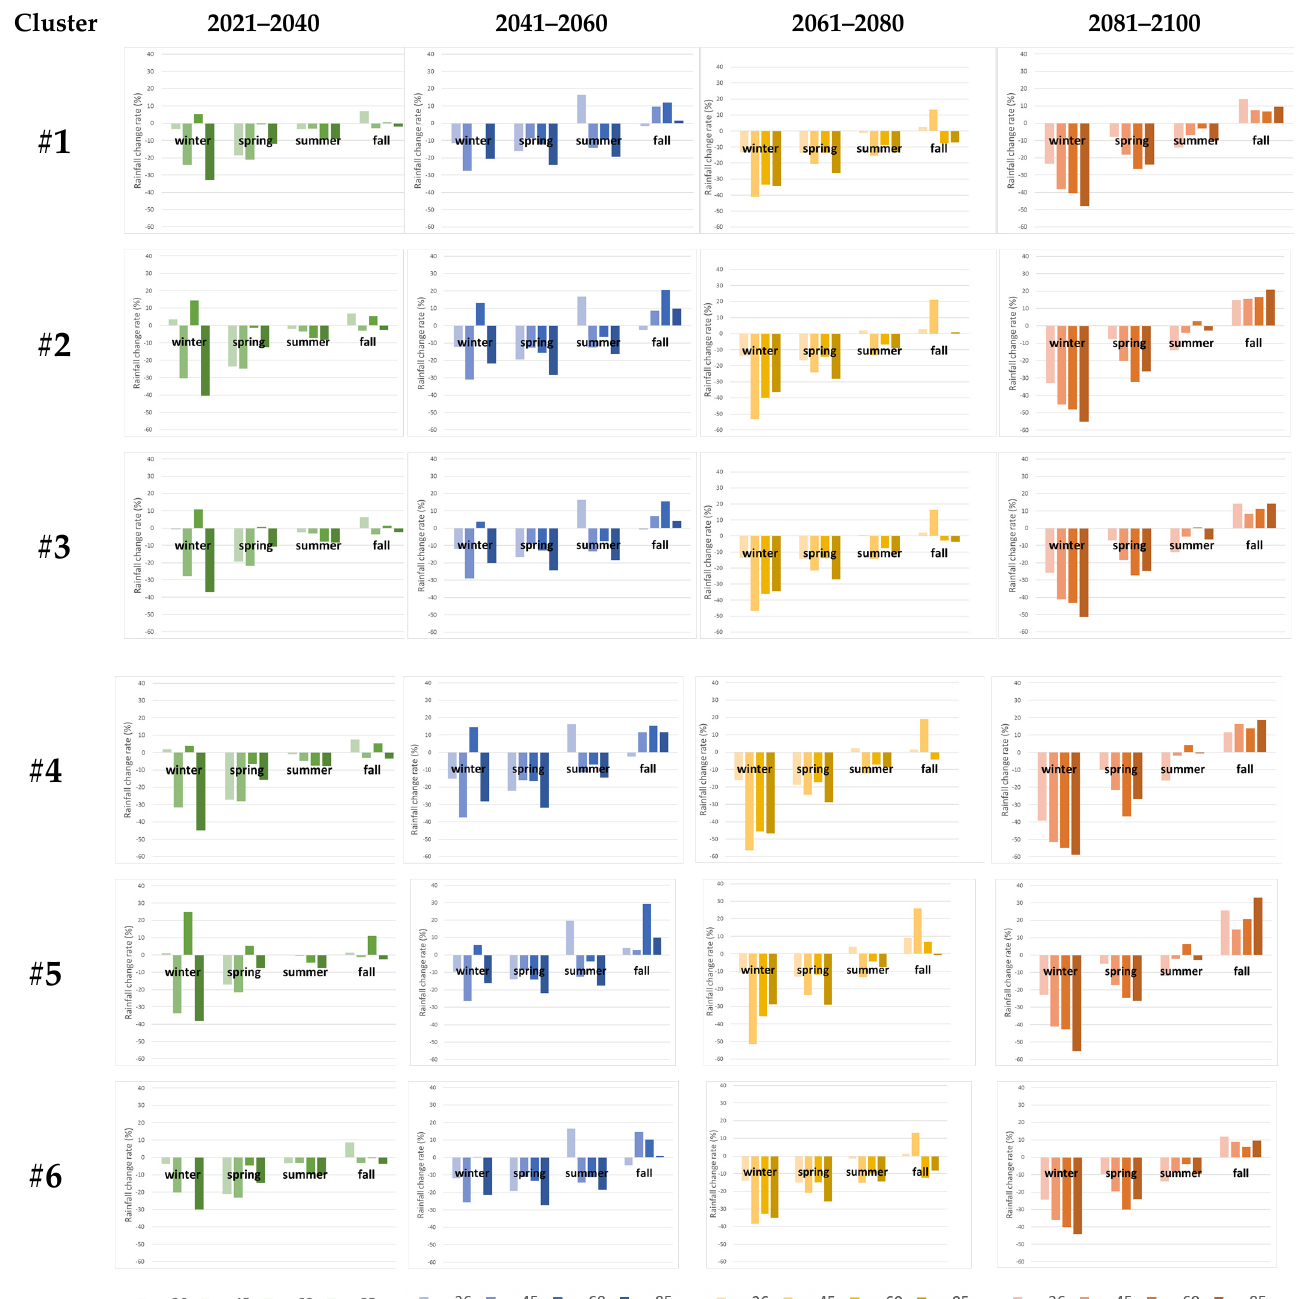
Figure A2. Average time series data of ( a ) NDVI, ( b ) rainfall, and ( c ) temperature extracted from selected 70 watersheds. The solid line represents the time series, the dotted line represents the linear trend, and the dashed line represents the two standard deviation bounds.